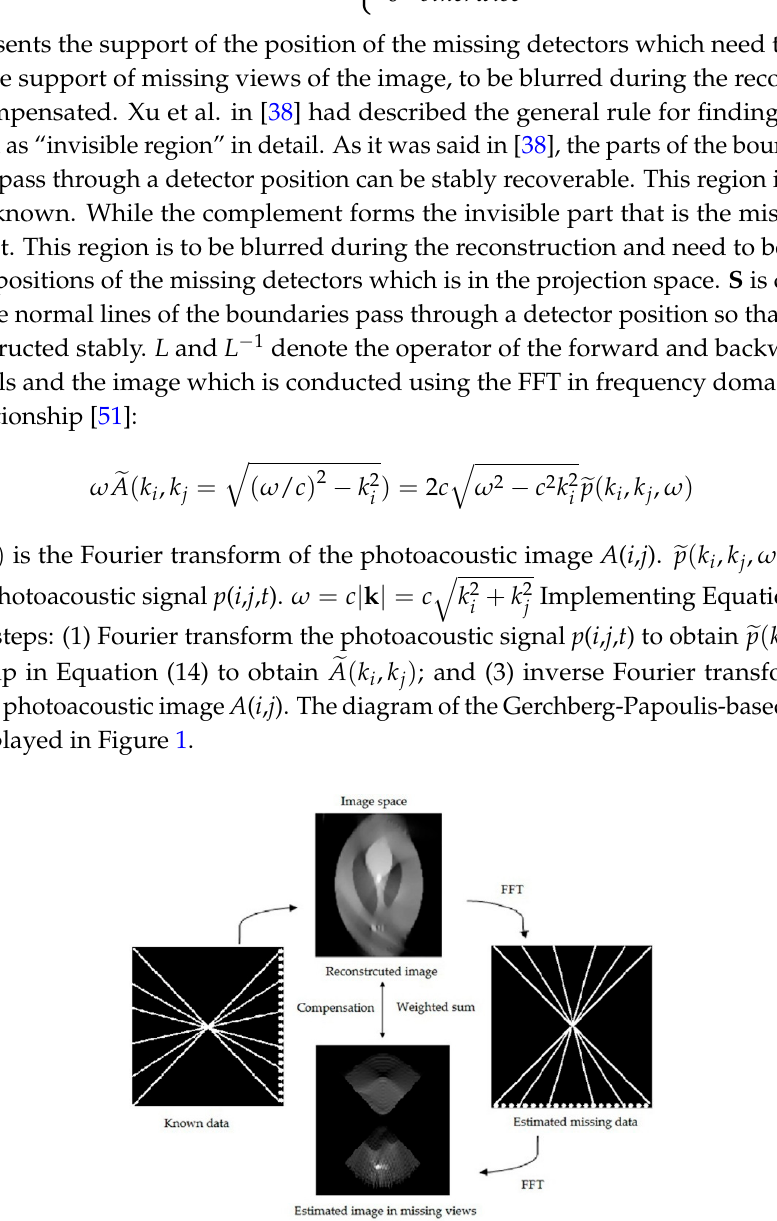
Figure 1. The diagram of the Gerchberg-Papoulis-based compensation method. The dots in the left and right subfigures refer to the positions of the known detectors (left) and the estimated detectors